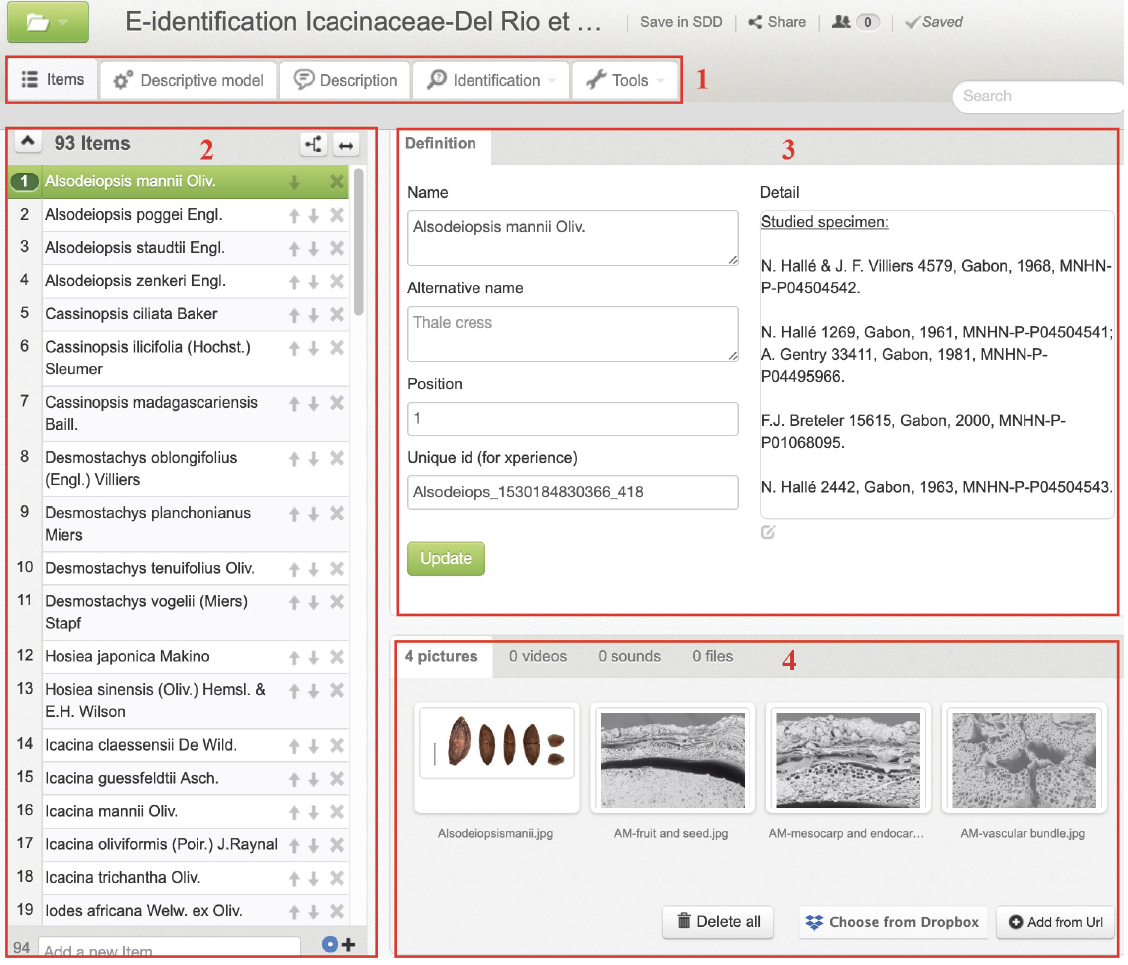
Fig. 3. Item view in the Xper 3 database. 1 . Tabs. 2 . List of items. 3 . Sheet of Alsodeiopsis mannii Oliv. with studied specimens. 4 . Pictures attached to the sheet. Image taken from Del Rio